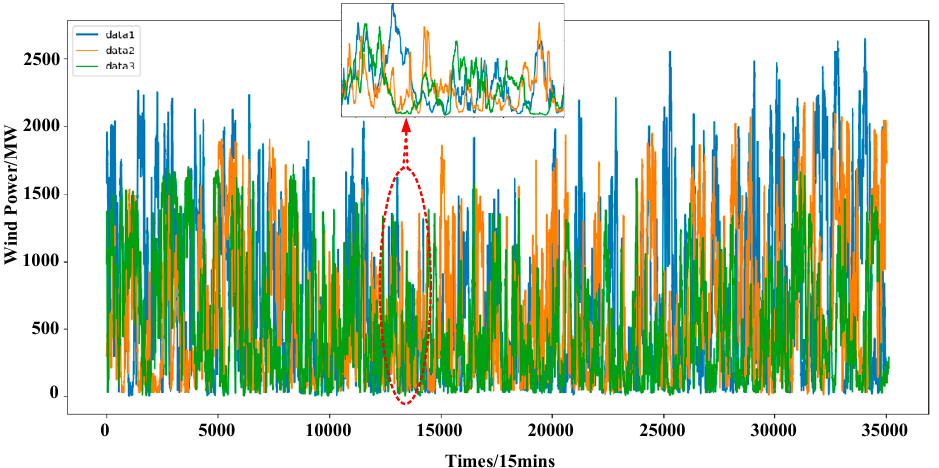
Figure 5. Power values generated by the wind turbine registered every 15 mins.